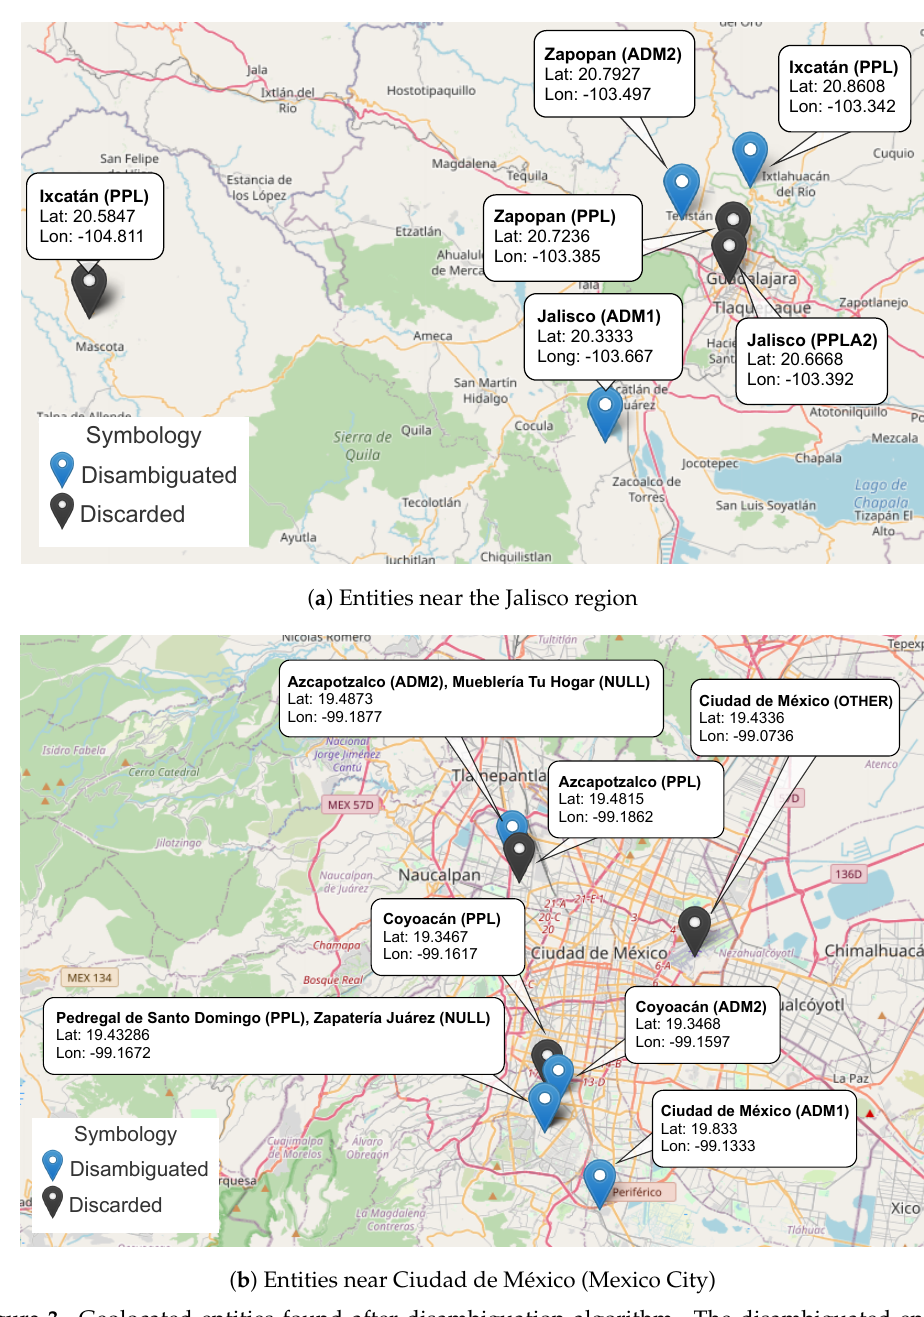
Figure 3. Geolocated entities found after disambiguation algorithm. The disambiguated entities preserve the inherent hierarchy after dynamic activation of rules. Entities tagged as discarded correspond to alternative locations detected by Algorithm